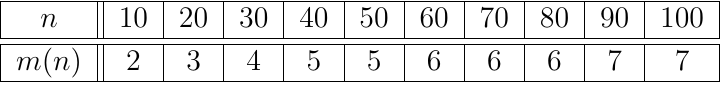
Table 11: Minimum largest term m ( n ) of forcibly connected graphical partitions of n .